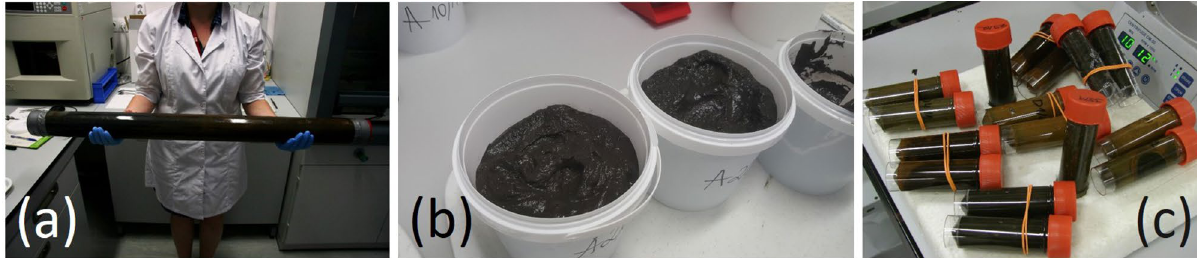
Figure 3. Storage of sapropel in the: ( a ) closed plastic containers, ( b ) removed from plastic containers and ( c ) selected samples for the extraction of active